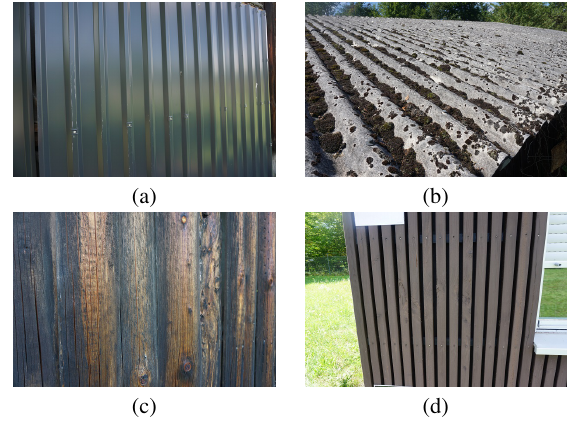
Figure 2. Samples of collected building material: (a) Metal , (b) Fibre Cement , (c) Wood and (d) Wood .